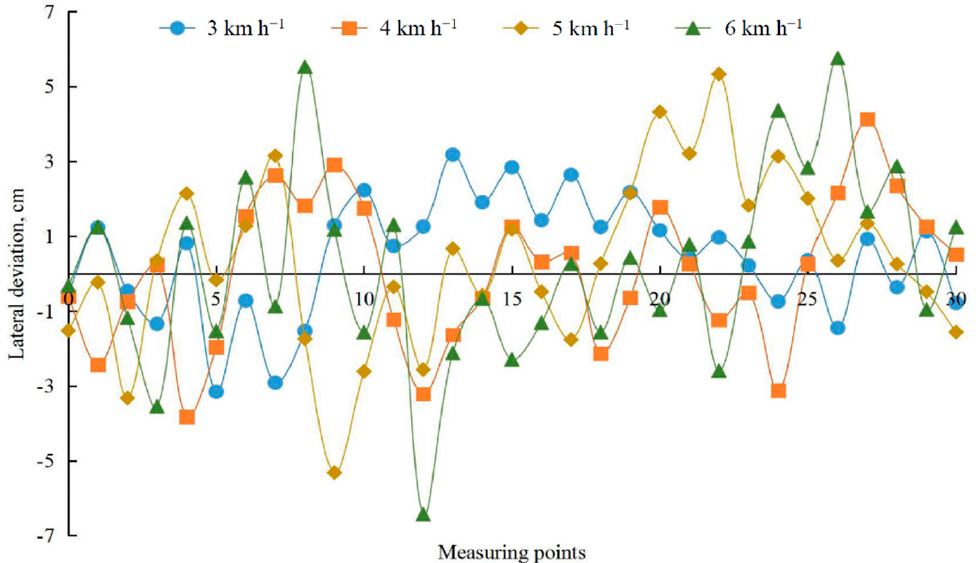
Figure 6. Lateral deviation of row-controlled operation at different speeds.